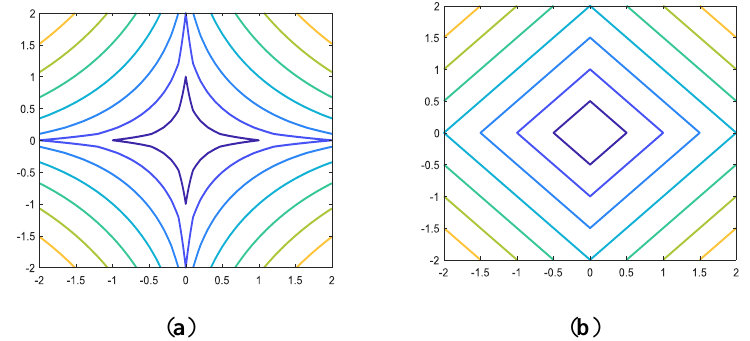
Figure 1. Contours of the Lp-pseudo-norm: ( a ) p = 0.5; ( b ) p = 1.